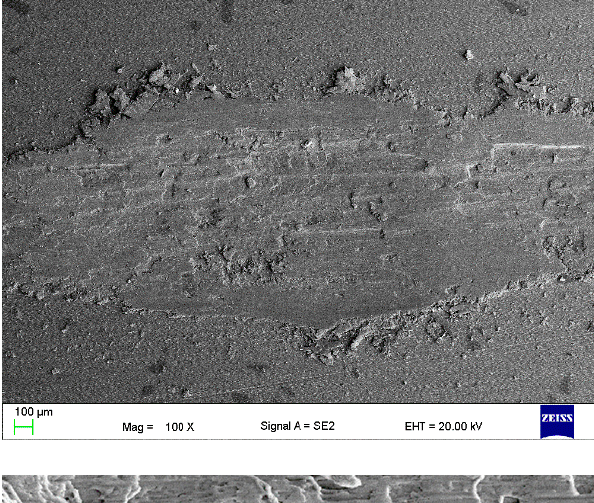
Figure 17. Wear track ( a , b ) of the tested CrAl v = 0.4 mm 3 /min layer and ( c ) wear debris.